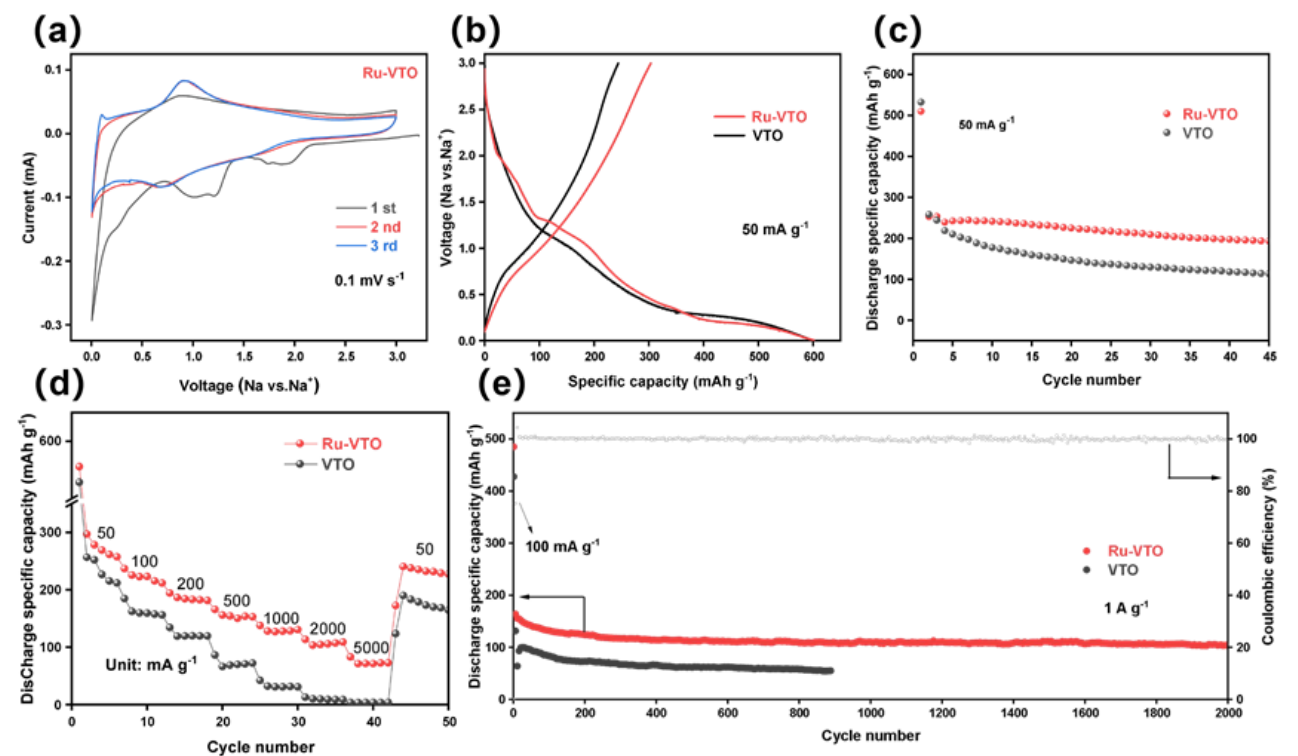
Figure 3. ( a ) CV test result for the initial three cycles of Ru-VTO at 0.1 mV s − 1 . ( b ) Initial galvanostatic discharge − charge voltage profiles at 50 mA g − 1 , ( c ) cycling performance at 50 mA g − 1 , ( d ) rate performance at a different density, and ( e ) long-term cycling stability at 1000 mA g − 1 for Ru-VTO and VTO.